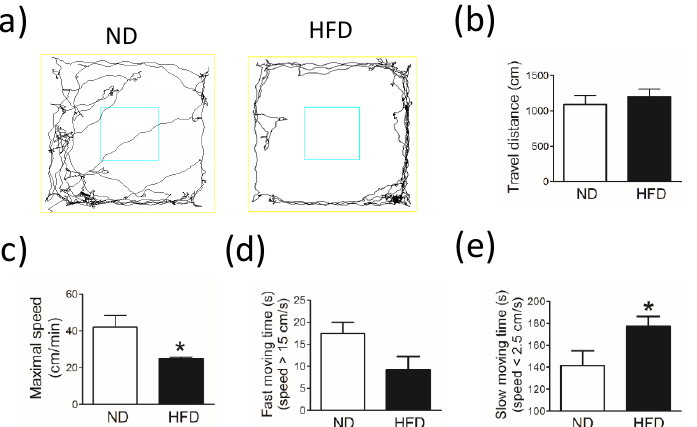
Figure 2. The spontaneous locomotor activity of middle-aged rats evaluated by using the open field test after rats were fed a normal diet (ND, control, n = 8) or 45% high-fat diet (HFD, n = 8) for 30 weeks. Data in a-e show the ( a ) travel tracks, ( b ) total travel distance (cm), ( c ) maximal travel speed (cm/min), ( d ) fast-moving time (s, speed >15 cm/s), and ( e ) slow-moving time (s, speed <2.5 cm/s). Behavior was analyzed by using a camera and an authorized image-tracking software (Panlab Smart video-tracking software). For ( b – e ), data are expressed as the mean ± SEM. * p < 0.05 vs ND group ( t -test).